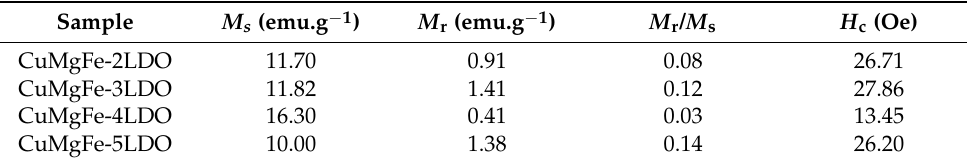
Figure 3. Magnetic hysteresis curves for the CuMgFe-xLDO catalysts. Figure 3 . Magnetic hysteresis curves for the CuMgFe-xLDO catalysts. Table 1. The magnetic properties of CuMgFe-xLDO Table 1. The magnetic properties of CuMgFe-xLDO catalysts.